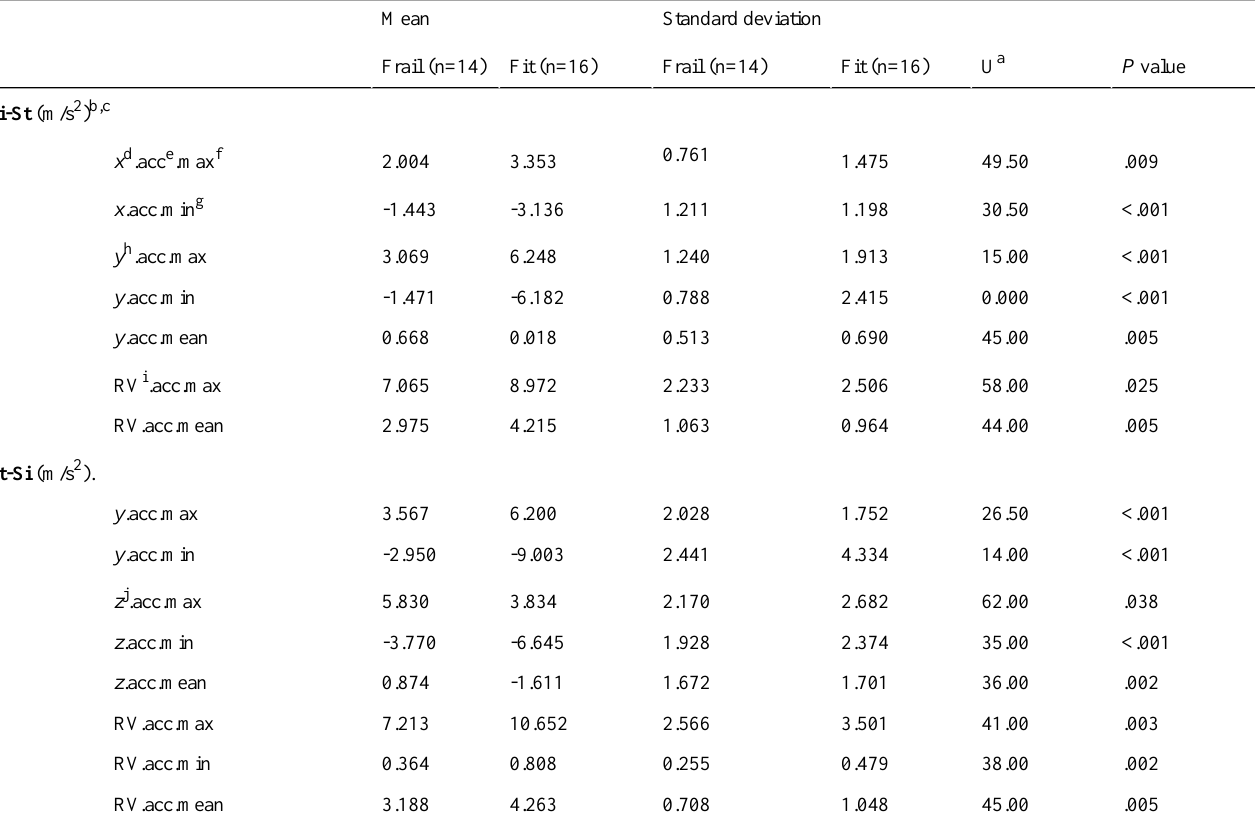
Table 2. Acceleration-based values from the Si-St and St-Si transitions (N=30).